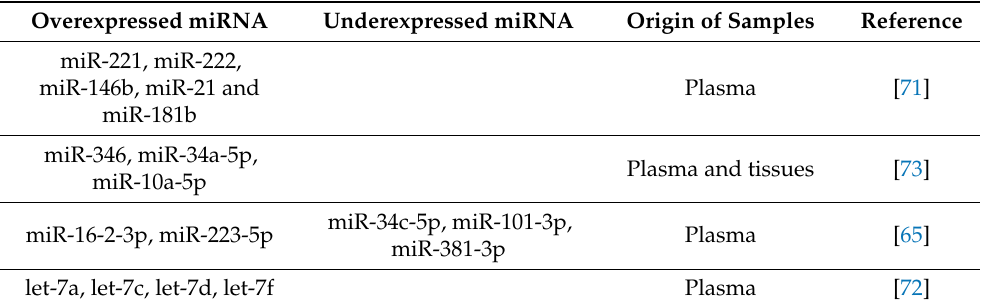
Table 3. Novel potential screening biomarkers determined by miRNA profiling. Overexpressed